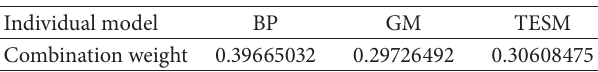
Table 3: Combination weight of combination forecasting model by TESM, BP, and